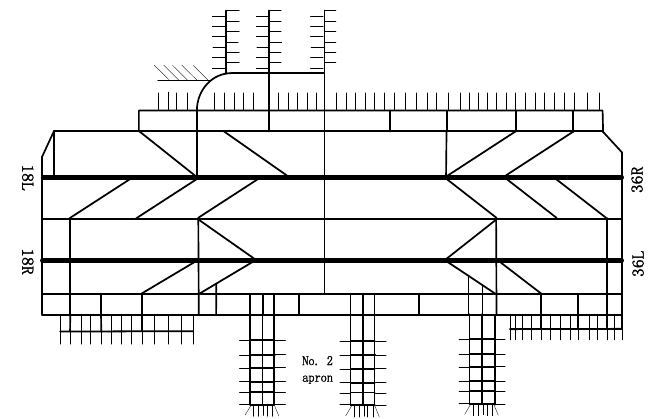
Figure 1. Network diagram of the Shanghai Hongqiao Airport taxiway system.